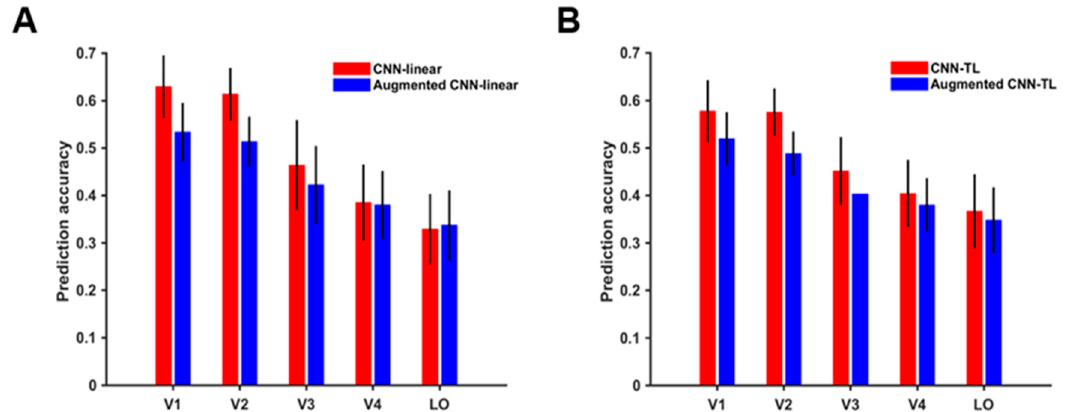
Figure 6. Prediction accuracies of visual encoding models for the ventral visual stream. ( A ) Prediction accuracies of the CNN-linear model and augmented CNN-linear model. The red column and blue column show the prediction accuracies of the CNN-linear model and the augmented CNN-linear model for a single ROI respectively. ( B ) Prediction accuracies of the CNN-TL model and augmented CNN-TL model. The red column and blue column show the prediction accuracies of the CNN-TL model and the augmented CNN-TL model for a single ROI, respectively.